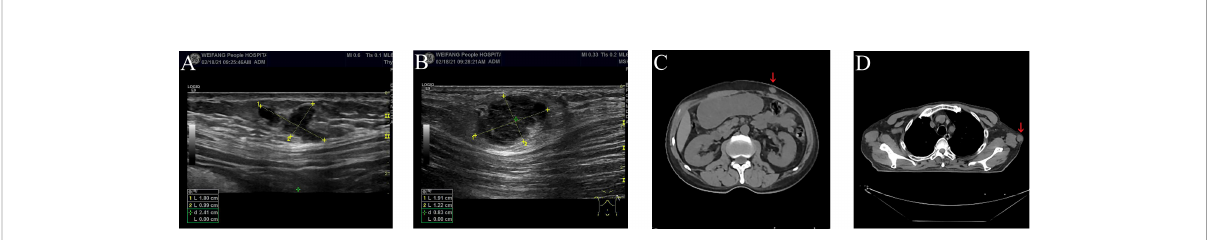
FIGURE 1 Ultrasound and CT scan of subcutaneous soft tissue metastases (A – D) . (A) Ultrasound scan of subcutaneous soft tissue metastasis in the left upper quadrant of the abdomen. (B) Ultrasound scan of subcutaneous soft tissue metastasis in the left posterior thorax. (C) CT scan of subcutaneous soft tissue metastasis in the left upper quadrant of the abdomen (red arrow). (D) CT scan of subcutaneous soft tissue metastasis in the left posterior thorax (red arrow).